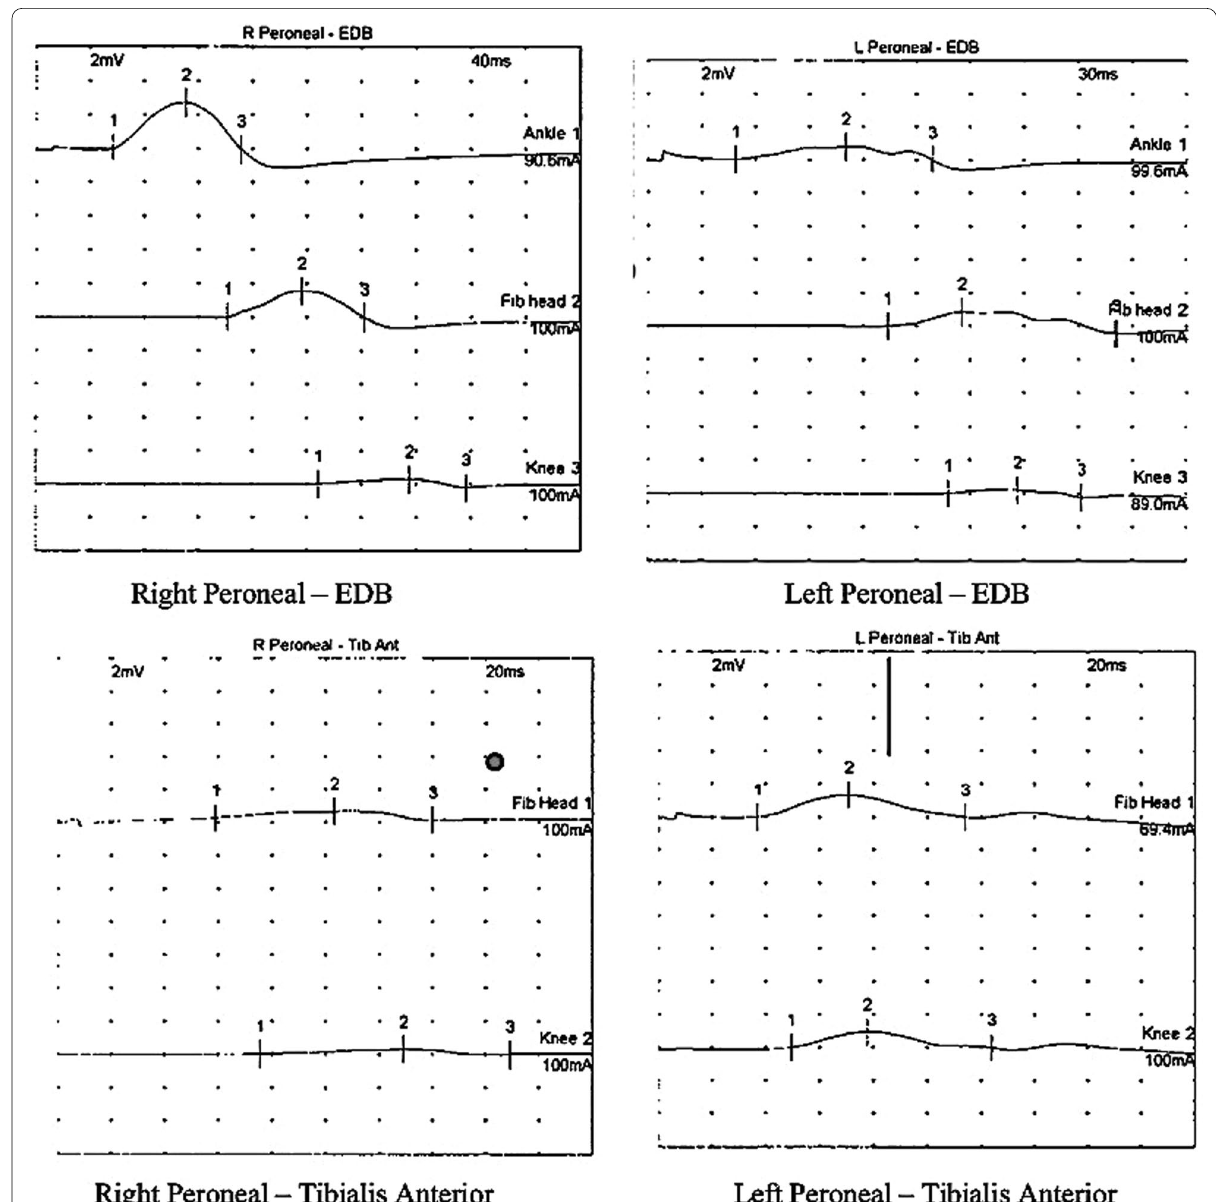
Fig. 1 Graphs of compound motor action potentials (CMAPs) of common peroneal nerves with recordings over extensor digitorum brevis (EDB) and anterior tibialis. Severe reduction in CMAP amplitude seen over bilateral peroneal nerves at the fibular head and knee